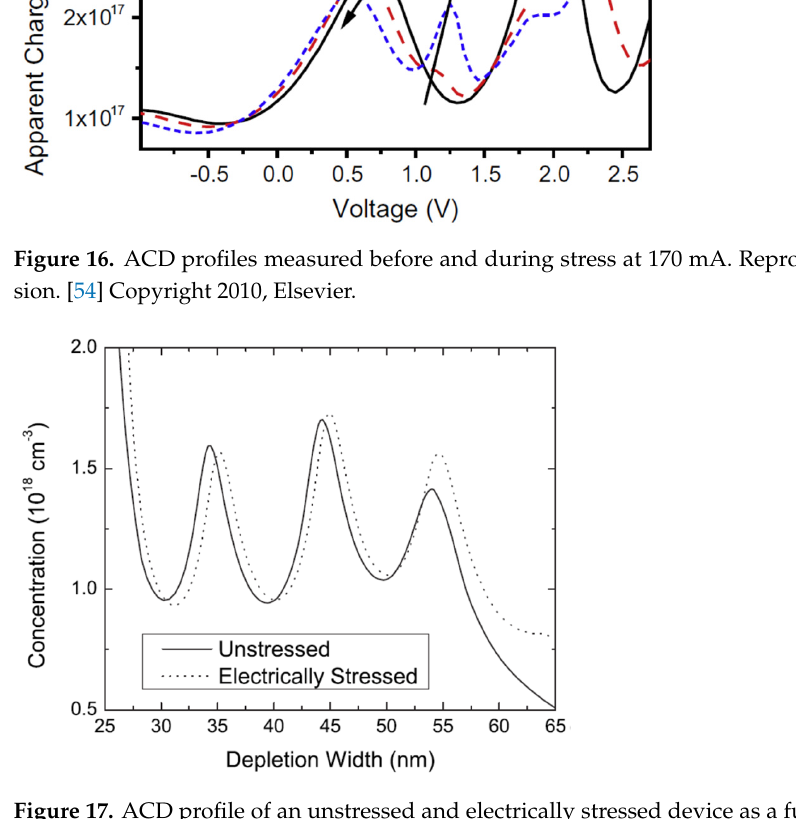
Figure 16. ACD profiles measured before and during stress at 170 mA. Reproduced with permis- sion. [54] Copyright 2010, Elsevier.